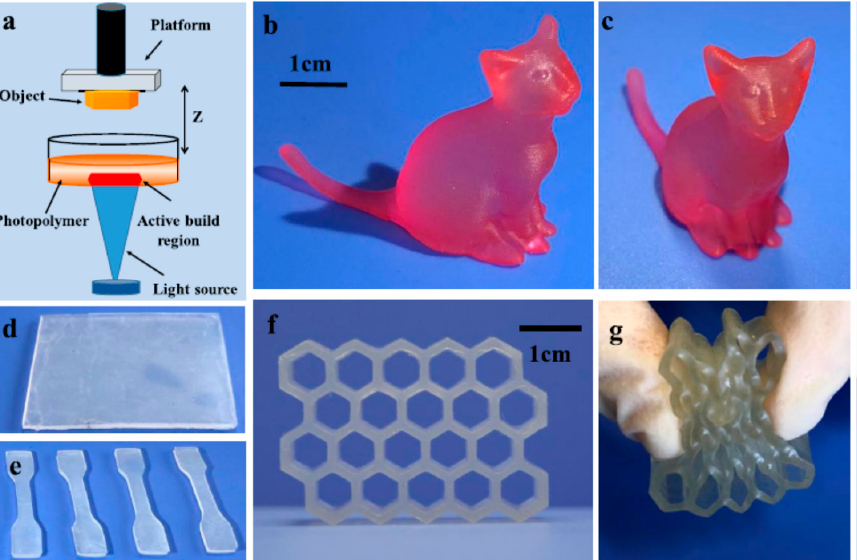
Figure 37. Elastomers based on cross-linked polydimethylsiloxane promising for application in 3D printing. Reproduced with permission from Ref. [139]. Copyright 2019 American Chemical Society. ( a ) Illustration of the working principle of DLP printing. ( b , c ) Photographs of the printed cat with the photopolymer resin L-0 (the red color is obtained by putting the printed cat in the red ink). ( d , e ) Photographs of the printed square samples for tensile test with the photopolymer resin HPsi-20 and the derived dumbbell-shaped test samples. ( f , g ) Photographs of the printed honeycomb-shaped sample with the photopolymer